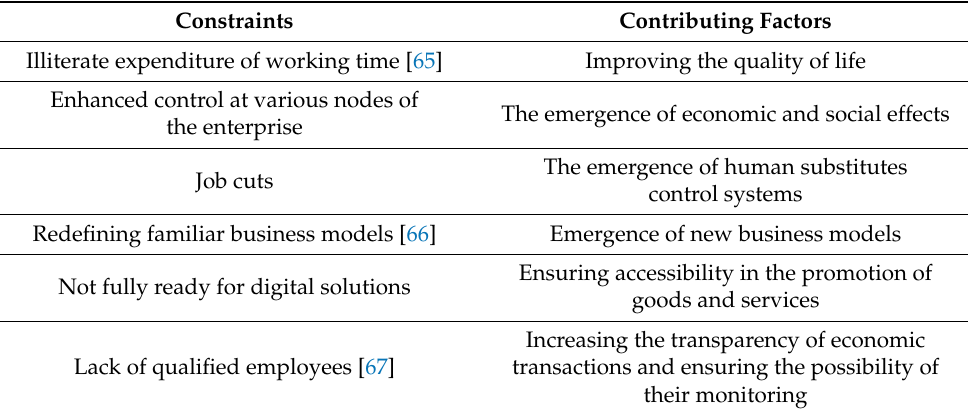
Table 9. Factors contributing to, and negatively affecting, digitalization in the energy sector (devel- oped by the authors).